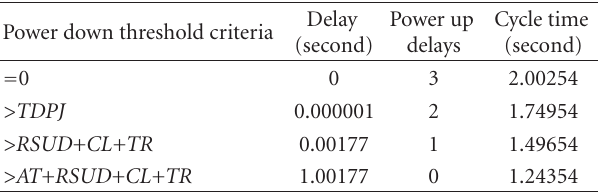
Table 13: Power Down Threshold cases for a closed system and their associated cycle